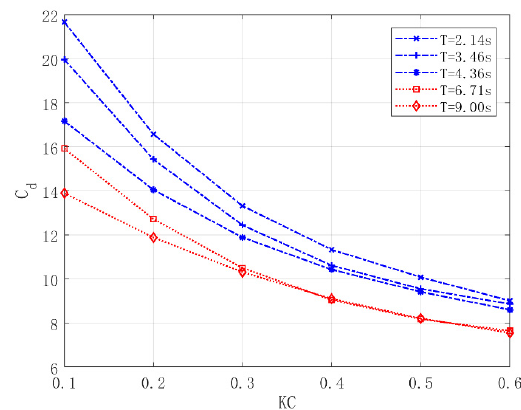
Figure 11. Drag coefficients of the heave plate.